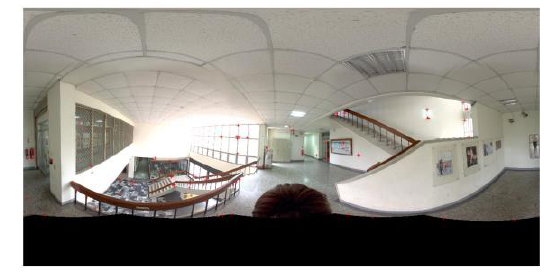
Figure 13(b). Control image of corresponding pair